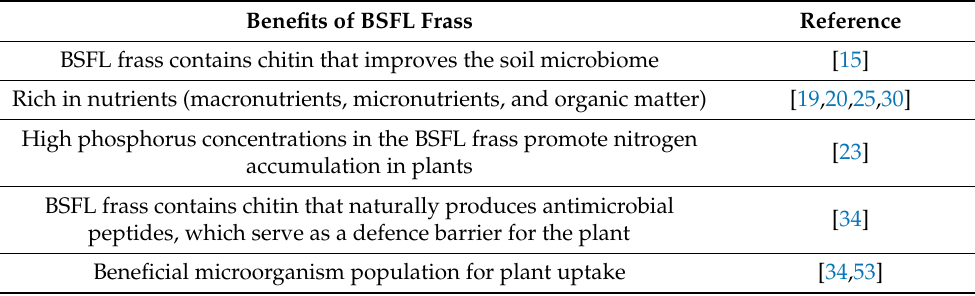
Table 4. Benefits of BSFL